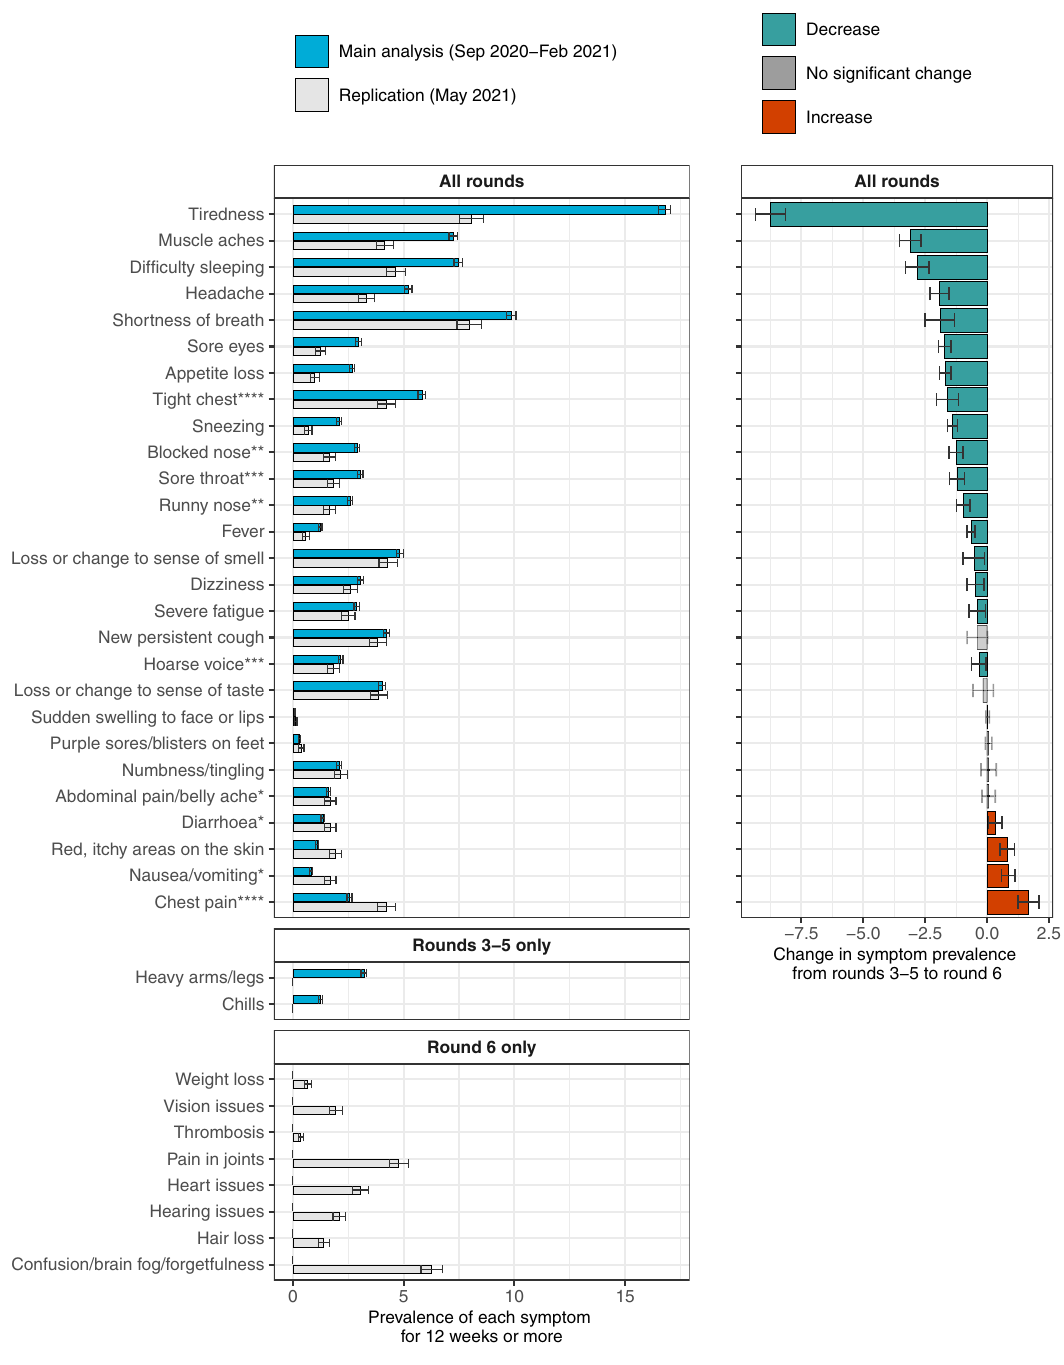
Fig. 3 Symptom prevalence in September 2020 – February 2021, and in May 2021. Prevalence of 37 symptoms surveyed across rounds 3 – 6 of REACT-2. Top panel shows symptoms that were surveyed in all rounds ( n = 606,434 observations); middle panel shows symptoms surveyed in rounds 3 – 5 only ( n = 508,707 observations); bottom panel shows symptoms surveyed in round 6 only ( n = 97,727 observations). Right panel compares symptom prevalence in the main study cohort (REACT-2 rounds 3 – 5, surveyed between October 2020 and February 2021) with the replication cohort (REACT-2 round 6, surveyed in May 2021). Asterisks indicate symptoms that were grouped in the round 6 survey. Green bars in the right panel indicate a decrease in symptom prevalence in round 6 compared with rounds 3 – 5. Error bars indicate 95% binomial con fi dence intervals of the